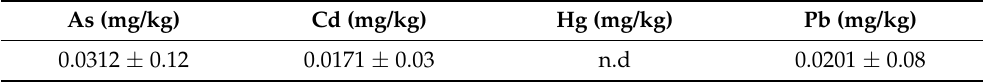
Table 4. Results obtained for selected elements reported as mean values ± SD, n = 3. As